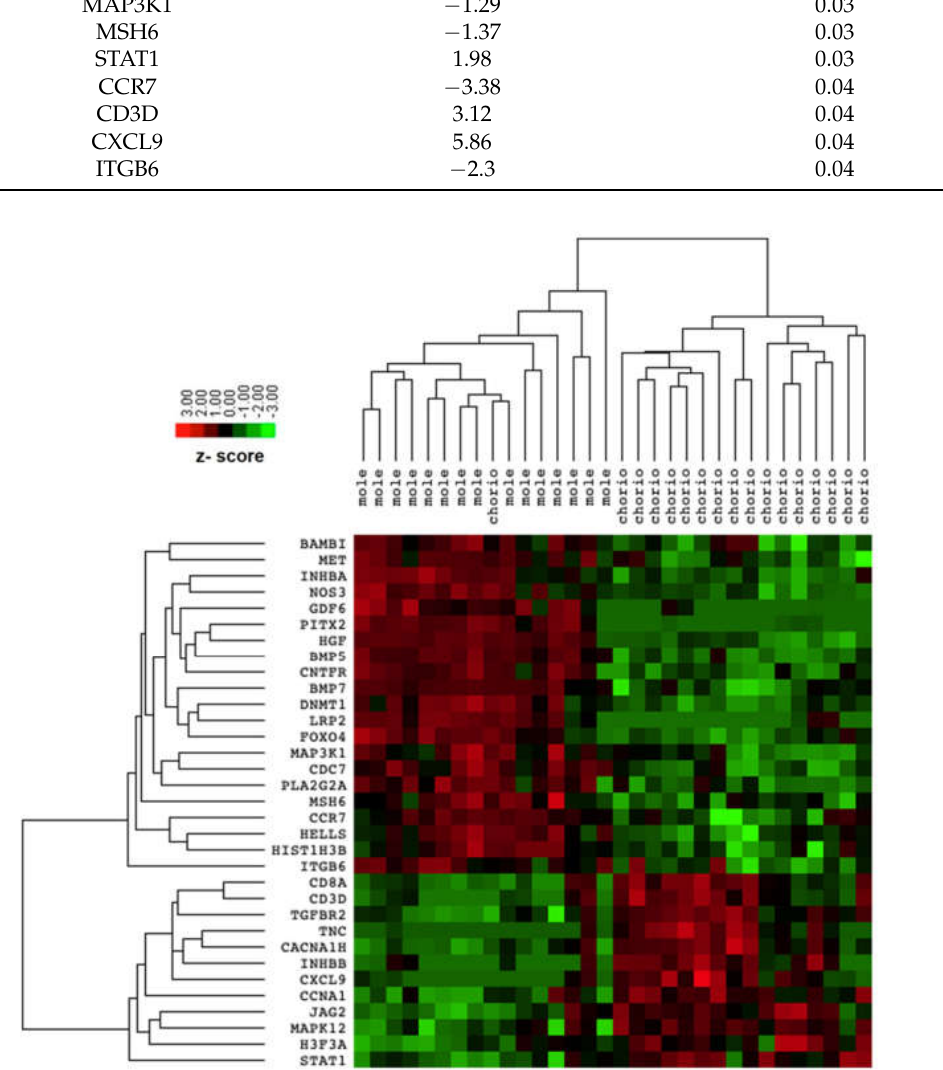
Figure 1. Heatmap of differentially expressed genes between complete mole and postmolar choriocarcinoma.